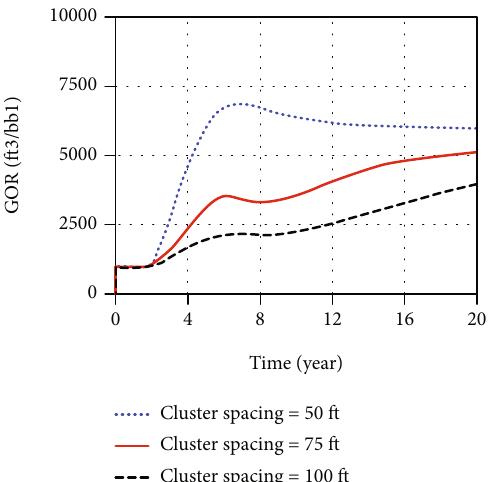
Figure 10: Simulated GOR vs. time for various fracture spacings (50-100ft). Widening cluster spacing can e ff ectively mitigate the GOR increasing